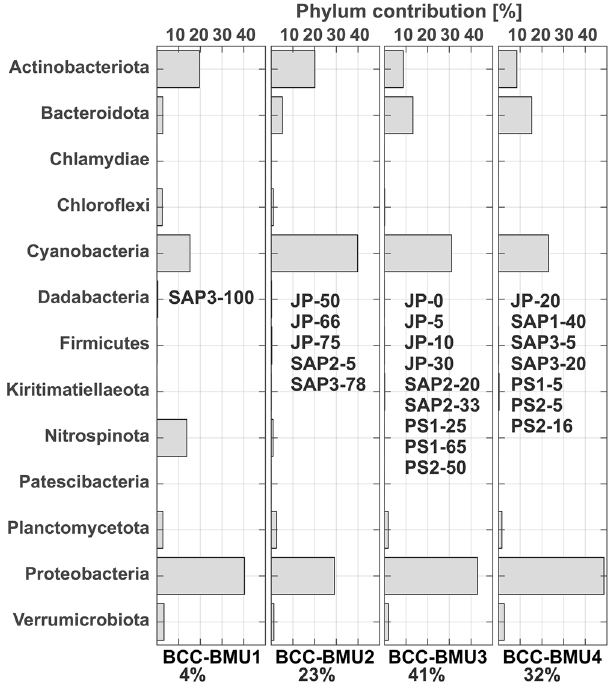
Figure 4. Characteristic phylum contribution (bacterial community composition-BCC-BMUs) modelled using Neural gas. Samples associated with a particular BMU are shown in the panels. The software MATLAB. version 7.10.0 (R2018). Natick, Massachusetts: The MathWorks Inc. (2018) (https:// www. mathw orks. com/) was used to generate the